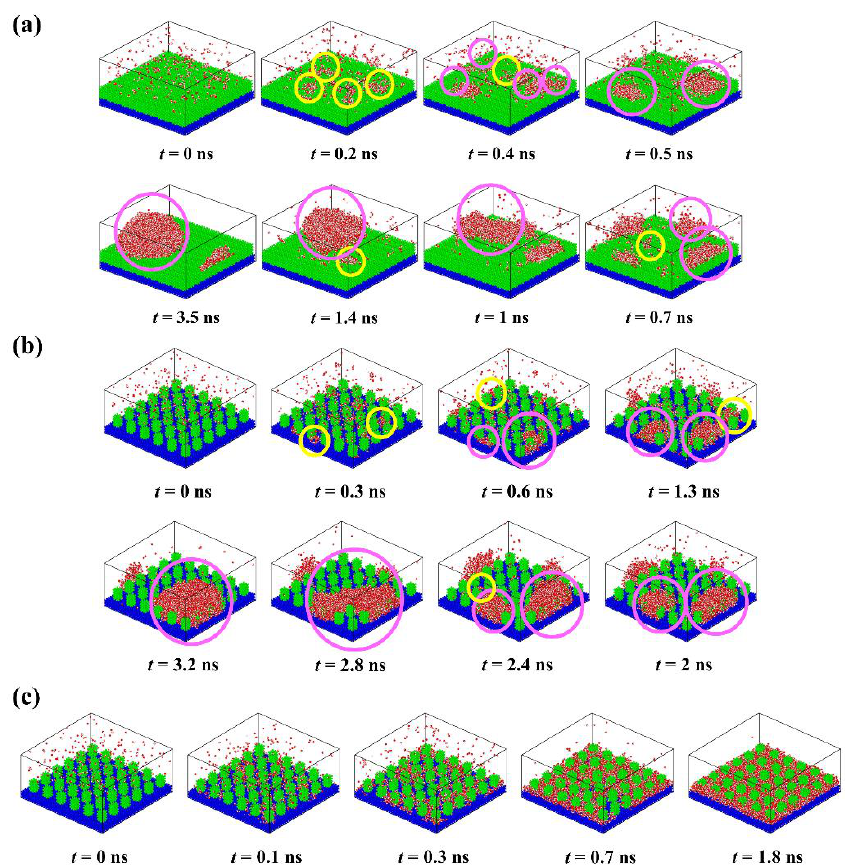
Figure 3. Time-lapse images of the condensation process on different nanopillar surface. ( a ) P 0.4 S 0.4 D 1 ; ( b ) P 0.25 S 0.25 D 3 ; ( c ) P 0.4 S 0.4 D 3 . (“ ” represents newly formed water clusters; “ ” represents pre-existing water clusters).